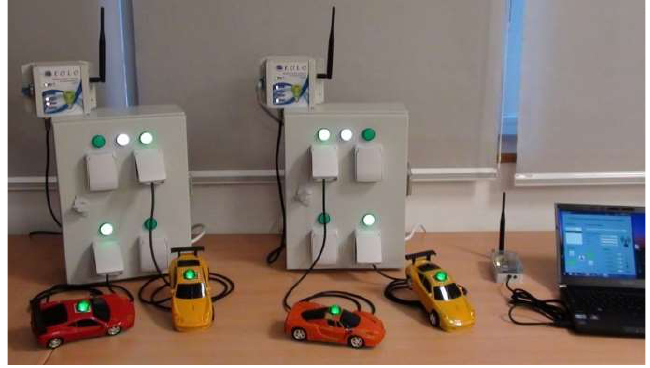
Figure 4. Laboratory tests of the final system before been released.